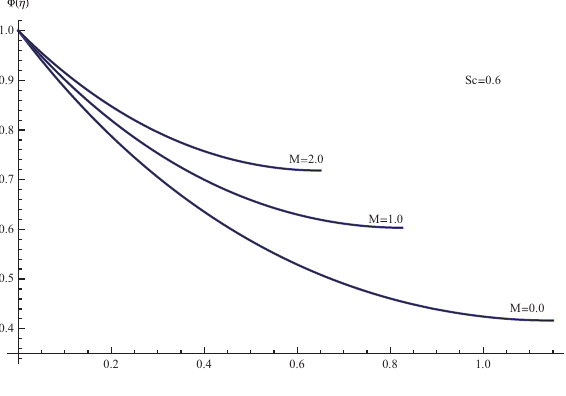
Figure 10: ( ) ϕ η for assorted quantities of β